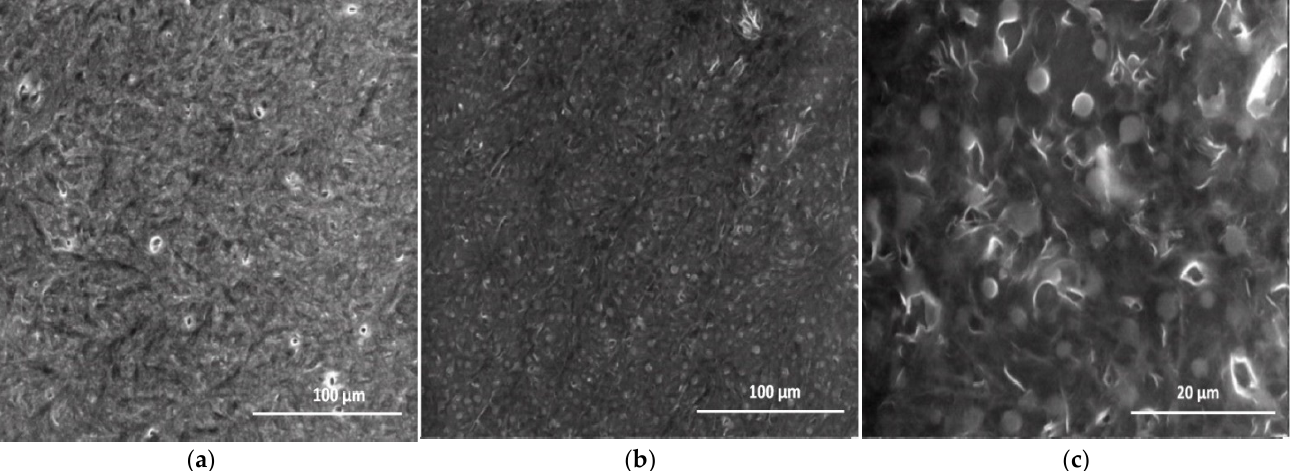
Figure 13. SEM micrograph for the microstructure of the PEBSA polymer matrix ( a ) and of PEBSA_Ty complex ( b , c ).